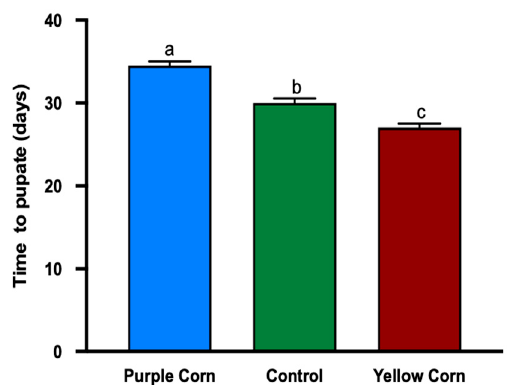
Figure 6. Mean time (days) to pupate of M. sexta caterpillars among different treatments. Means followed by different letters are statistically significantly different (Kruskal–Wallis tests, Dunn’s multiple comparison test, p < 0.05).